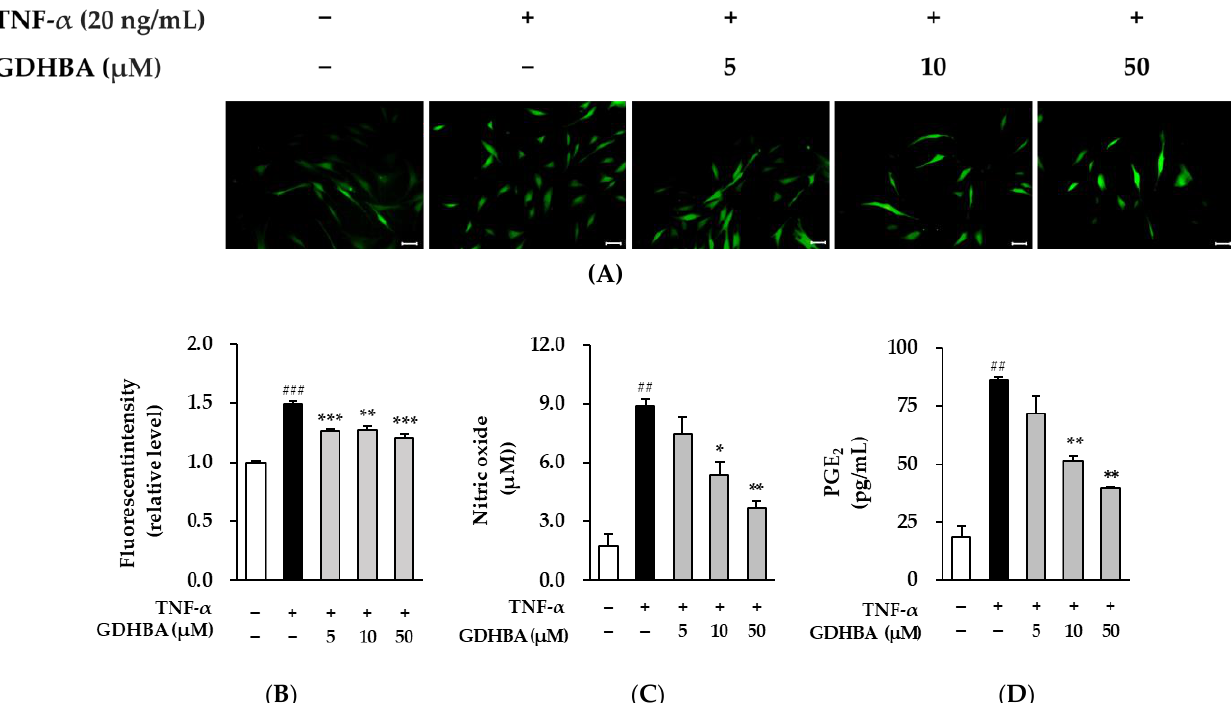
Figure 2. Effect of GDHBA on ROS ( A , B ), NO ( C ), and PGE 2 production ( D ) in TNF- α stimulated HDFs. HDFs were pretreated with 5, 10, and 50 μM GDHBA for 1 h and incubated for 15 min and 24 h with TNF- α (20 ng/mL). Scale bar, 50 μm ( A , B ) Fluorescence intensity, and ROS production were observed using 10 µM DCFDA for 15 min. ( B ) Nitrite content in the cell culture supernatant was measured using the Griess assay. ( C ) PGE 2 production was quantified using an ELISA kit. Each bar represents mean ± SEM. ## p < 0.01 and ### p < 0.001 versus normal control. * p < 0.05, ** p < 0.01, and *** p < 0.001 versus stimulus alone.